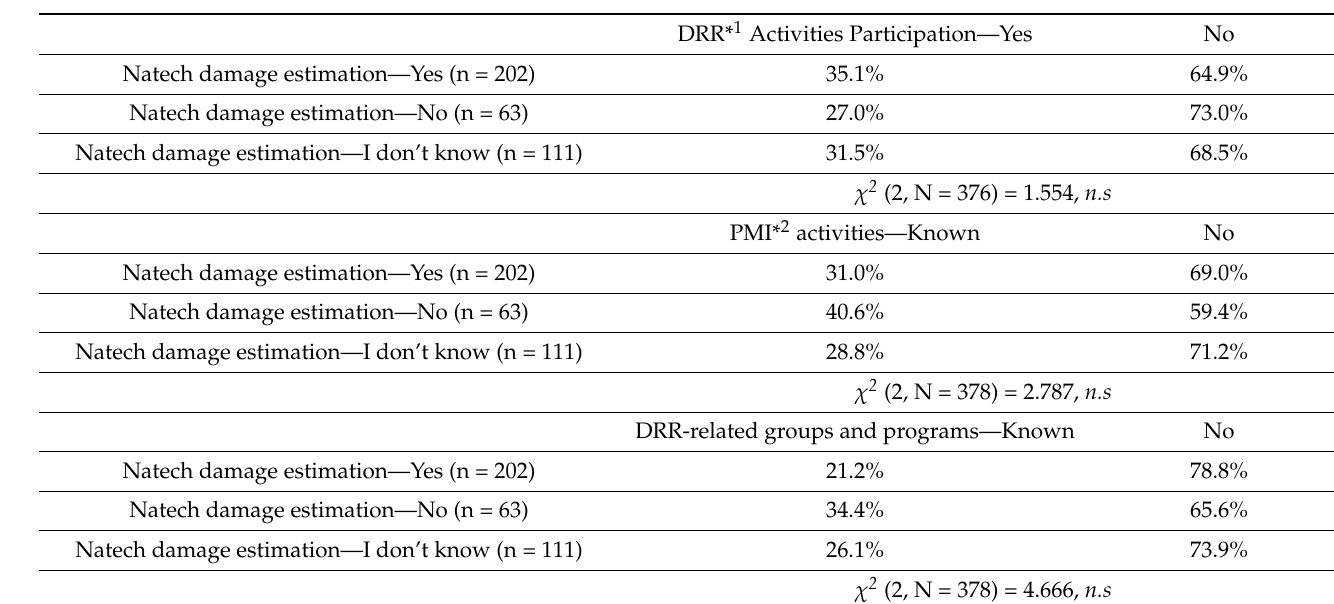
Table 8. Natech damage estimation and preparedness (N =